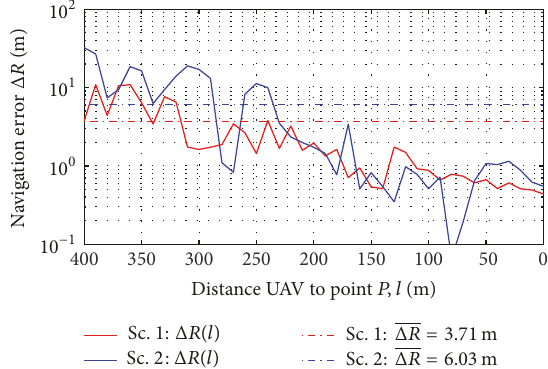
Figure 6: Navigation error for Sc. 1 and Sc. 2 and 𝑇 2 .